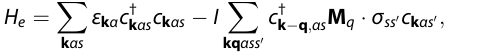
(cid:4) (cid:5) of RuO 2 3 a